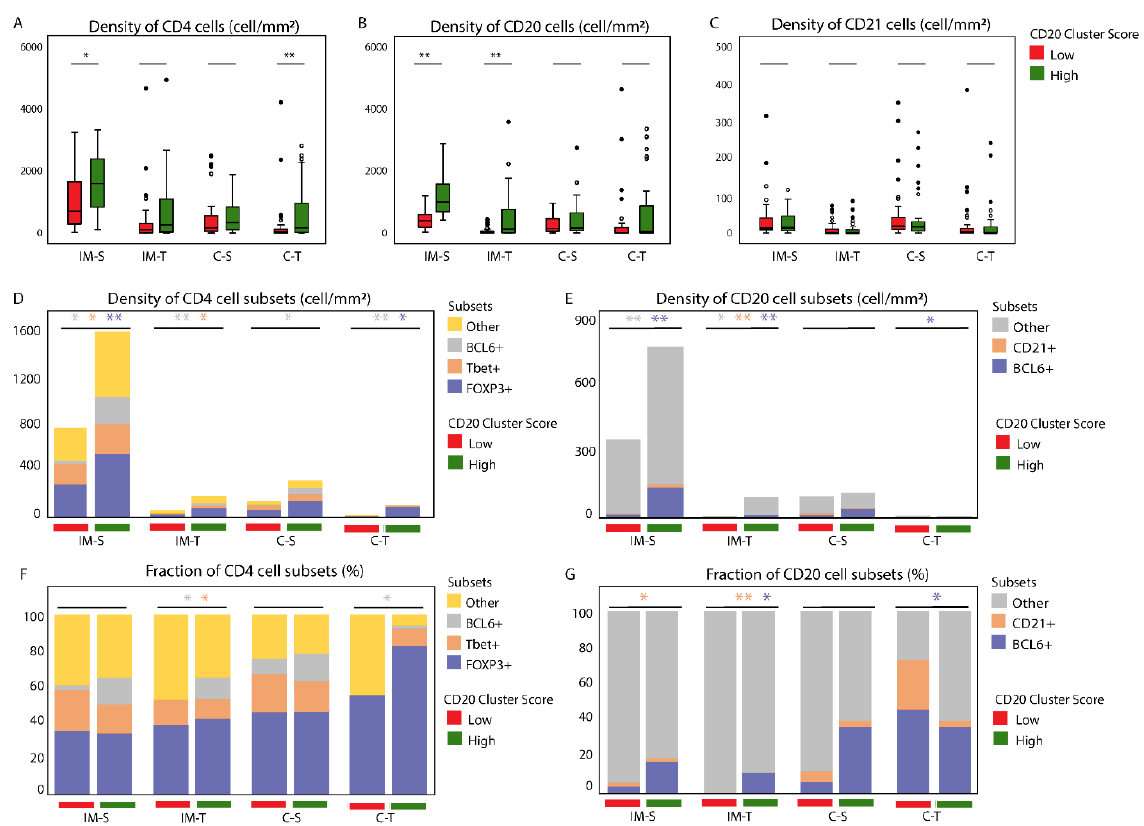
Figure 2. The CD20 cluster score associates with high densities of Treg, Th1 and Tfh, as well as GCB cells in the IM-S. ( A – C ) Box plots showing CD4 (A), CD20 (B), and CD21 (C) cell densities according to the CD20 cluster score in all 4 regions; ( D , E ) bar plots showing median densities of CD4 T cell subsets and CD20 B cell subsets according to the CD20 cluster score in all 4 regions; ( F , G ) the median fractions of CD4 and CD20 subsets according to the CD20 cluster score in all 4 regions. Statistical significance according to the Mann–Whitney U test is shown above individual plots, * p < 0.05, and ** p < 0.01. Colored asterisks indicate a difference between the high versus low CD20 cluster score for the corresponding cell subset. IM-S, invasive margin stroma, IM-T, invasive margin tumor, C-S, center stroma, and C-T, center tumor.